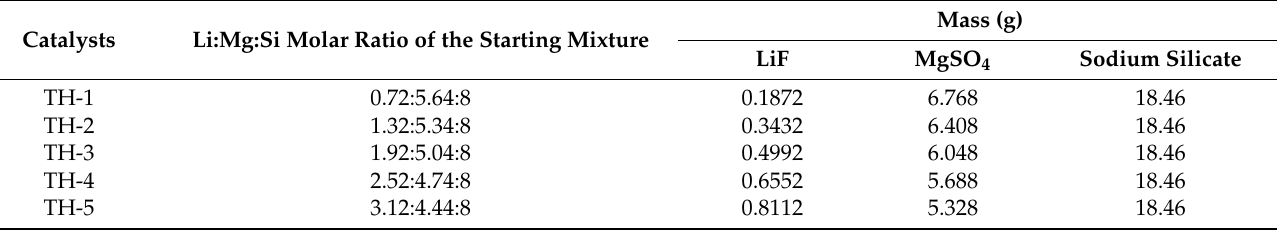
Table 2. The molar ratio and mass of the